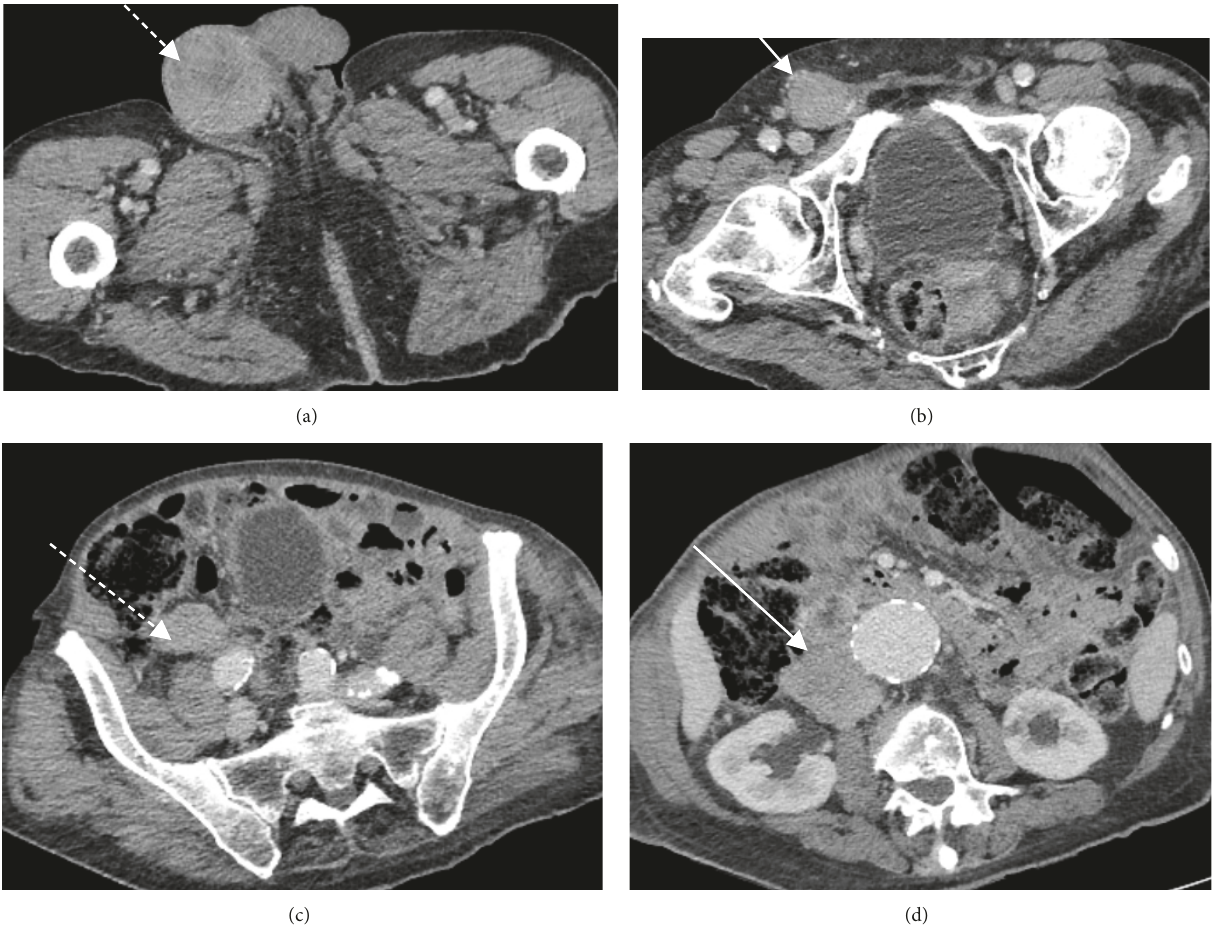
Figure 5: (a) Axial CT image with contrast at the level of the scrotum demonstrates a large, heterogeneous, right testicular tumour (dashed white arrow). (b) Axial CT image with contrast at the level of the right inguinal canal demonstrates extension of homogeneous soft tissue along the right spermatic cord in the inguinal canal (white arrow). (c) Axial CT image with contrast at the level of the common iliac vessels demonstrates tumour anterior to the right iliac artery and vein (dashed white arrow) along the course of the right gonadal vein. (d) Axial CT image with contrast at the level of the right renal pelvis demonstrates soft tissue in the retroperitoneum along the right gonadal vein to the level of its insertion into the inferior vena cava (white